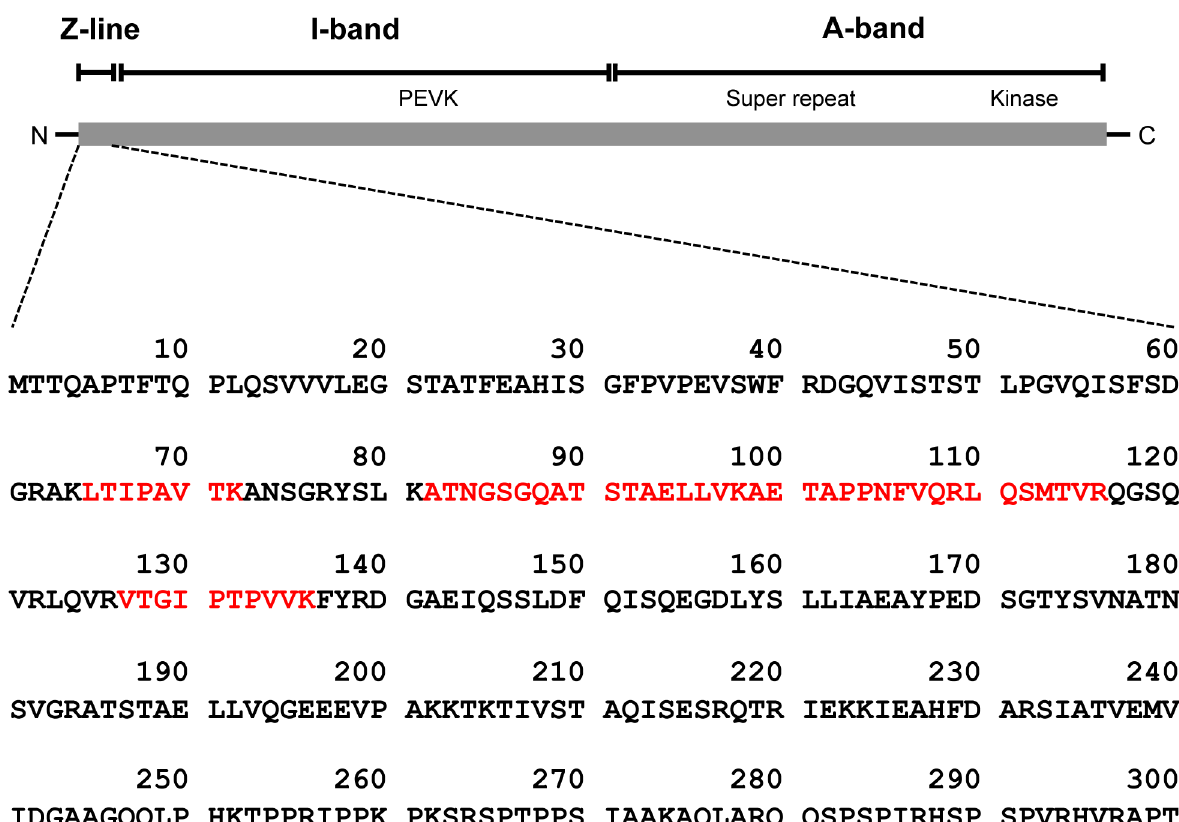
Fig 2. A schematic diagram of human titin. The N-terminal titin fragment was identified with the protein databasesearch engine MASCOT. The sequencesin red text were detected with LC–MS/MS.